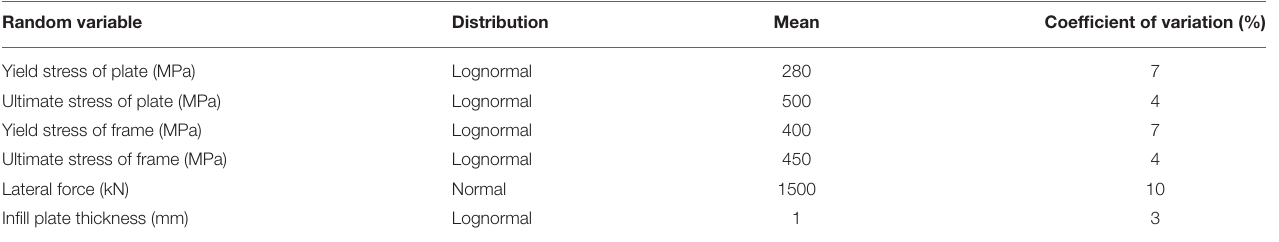
TABLE 2 | Statistical properties of random